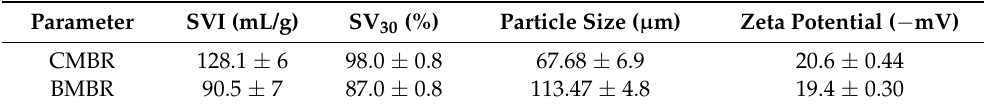
Table 2. Characterization of mixed-liquor suspension from the conventional MBR (CMBR) and the biochar MBR (BMBR) at the end of the experimental trial.